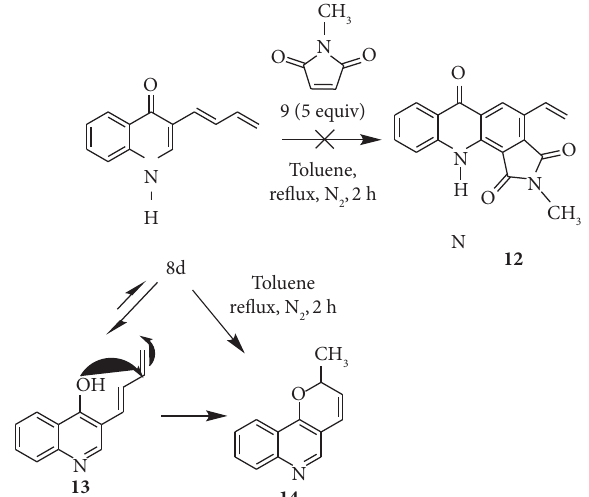
Scheme 4: Synthesis of 2-methyl-2( H )-pyrano[3,2-c]quinoline ( 14 ) starting from (1 E ,3 E )-3-(buta-1,3-dien-1-yl)quinolin-4(1 H )-one ( 8d